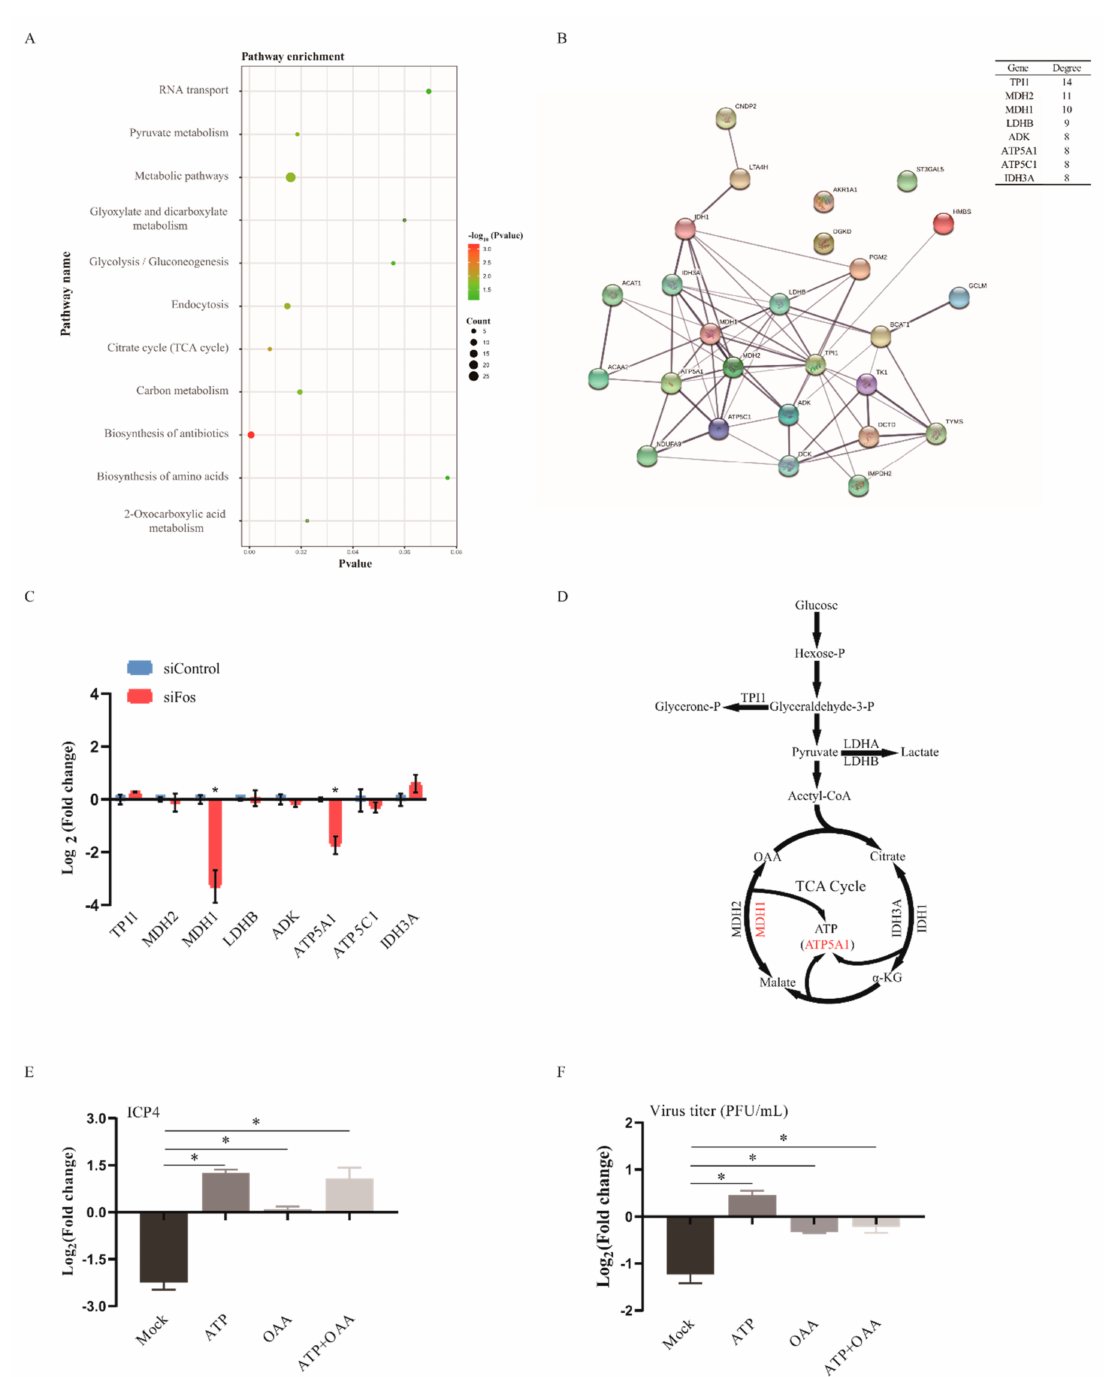
Figure 3. Effects of Fos silencing on metabolic genes in ILTV-infected LMH cells. ( A ) KEGG pathway enrichment analysis of the DEGs in DF-1 cells. The X -axis represents the p -values, the Y -axis represents the pathway name, and the color represents the − log 10 ( p value); the size of the point represents the number of genes. ( B ) The interaction network of